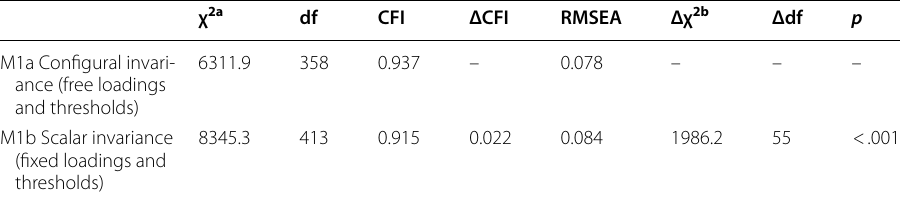
Table 9 Testing measurement invariance between girls and boys for ICT Engagement scales for